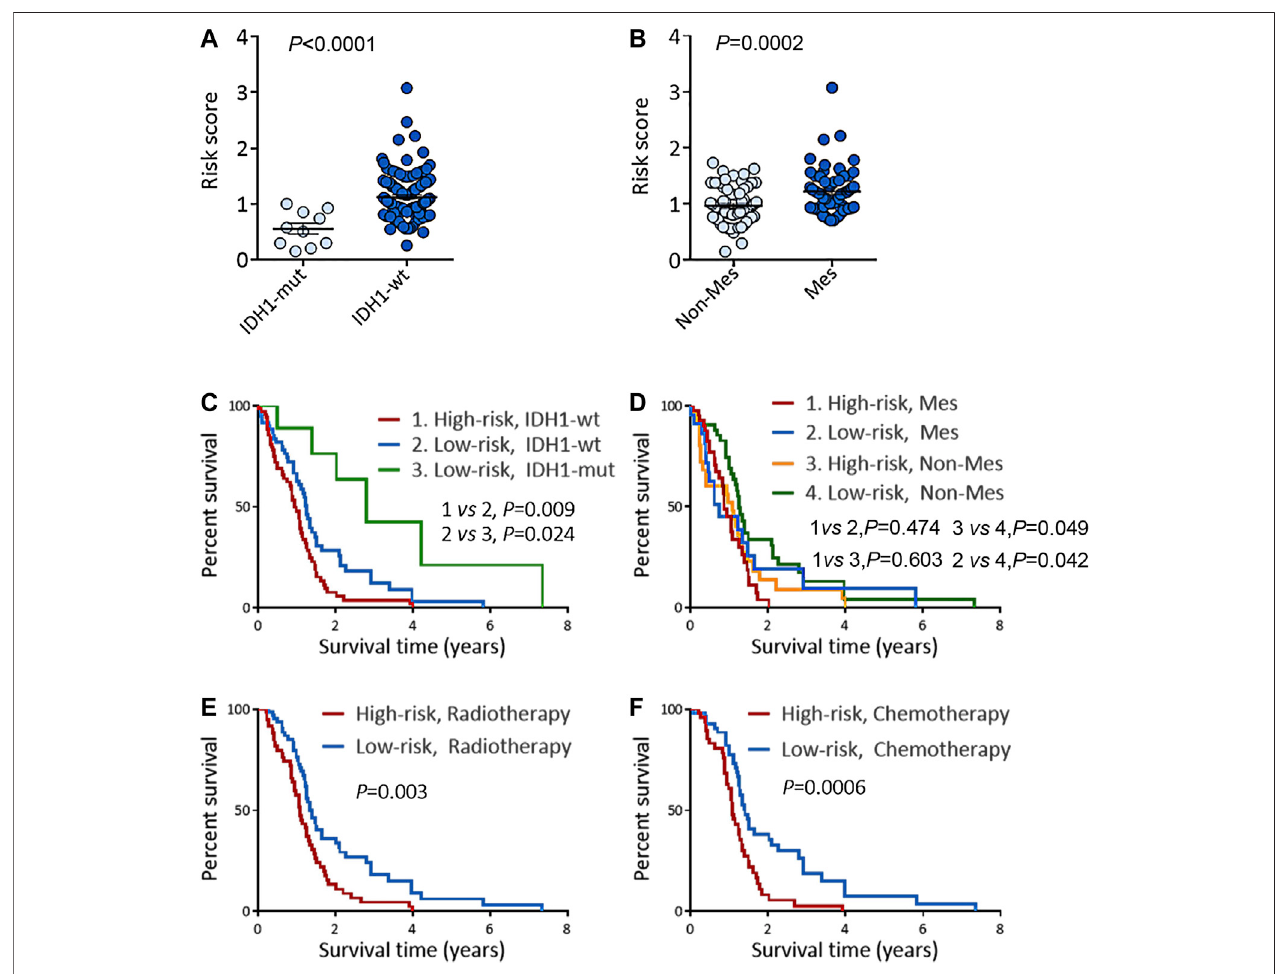
FIGURE5| RiskscorepredictstheprognosisandtreatmentresponseinTCGAGBMcohort. (A) RiskscoresinIDH1-mutGBMandIDH1-wtGBM. (B) Riskscores in Non-Mes GBM and Mes GBM. (C – D) KM OS analysis of TCGA GBM patients strati fi ed by risk score combined with IDH1 status (C) and combined with expression subtypes (D) . (E – F) KM OS analysis of TCGA GBM patients with radiotherapy (E) , or TMZ chemotherapy (F) according to the risk score. KM, Kaplan-Meier; OS, overall survival; IDH, isocitrate dehydrogenase; IDH1-wt, IDH1-wild type; IDH1-mut, IDH1-mutation; Mes, mesenchymal; Non-Mes, non-mesenchymal; TMZ, temozolomide. Data are shown as mean ±